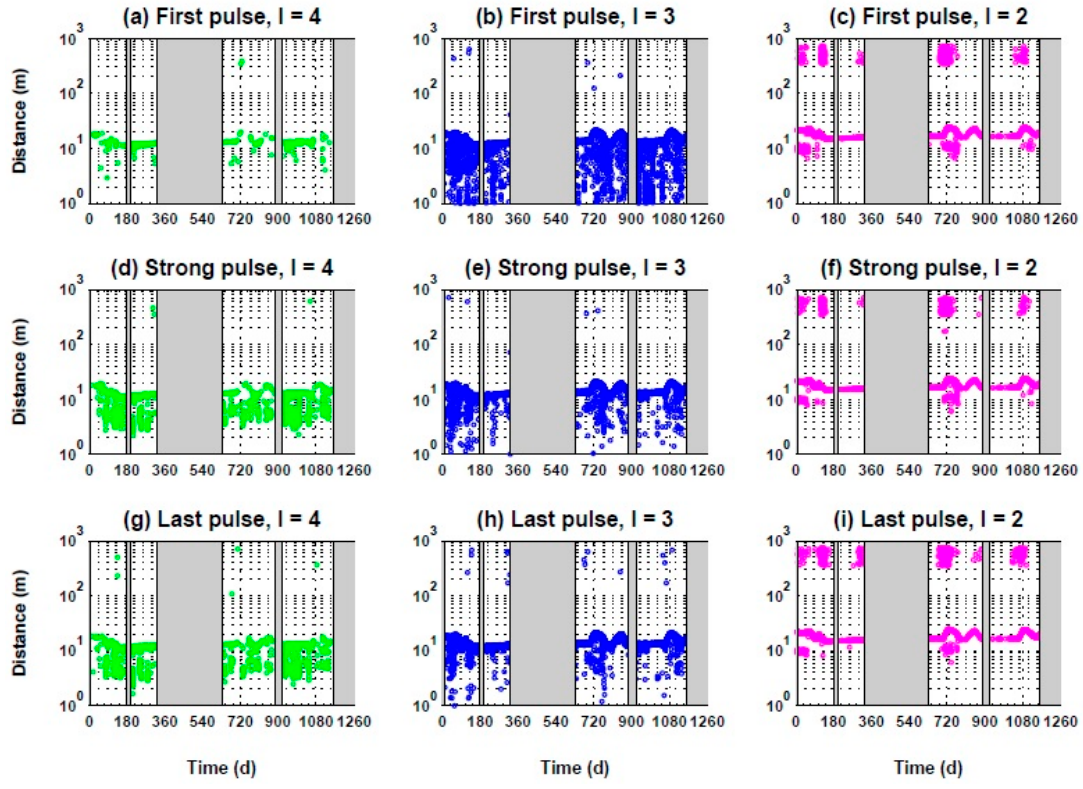
Figure 7. ( a – i ) Raw distance data measured by the test Lidar during the field experiment at the Valsequillo reservoir (same legend as Figure 6)